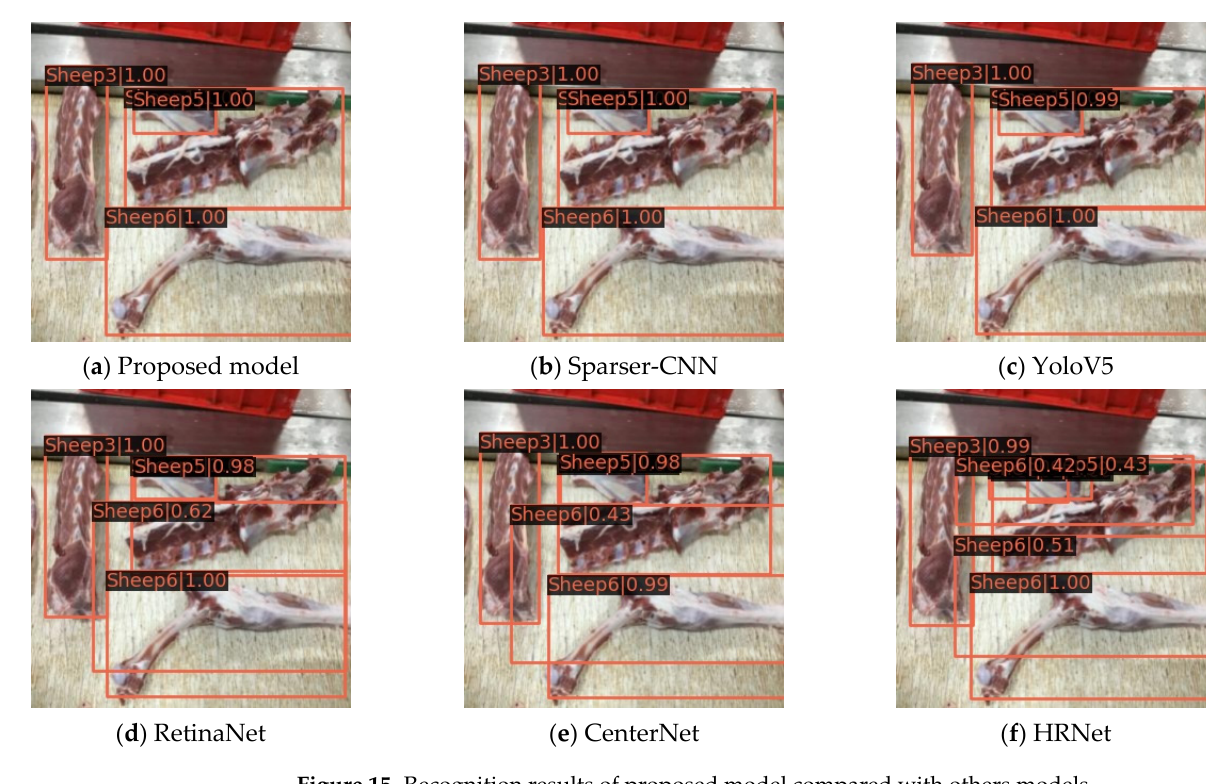
Figure 15. Recognition results of proposed model compared with others models.